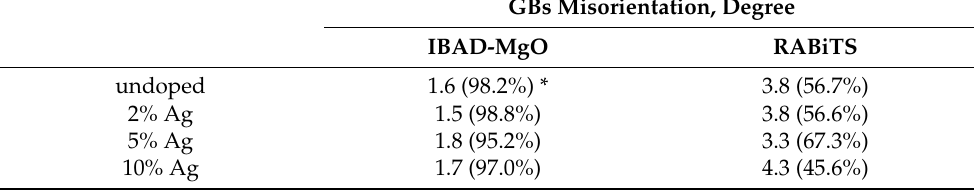
Table 1. Mean values for the grain boundaries’ misorientation distribution determined from EBSD measurements for undoped and Ag − doped YBCO films grown on RABiTS and IBAD − MgO- based